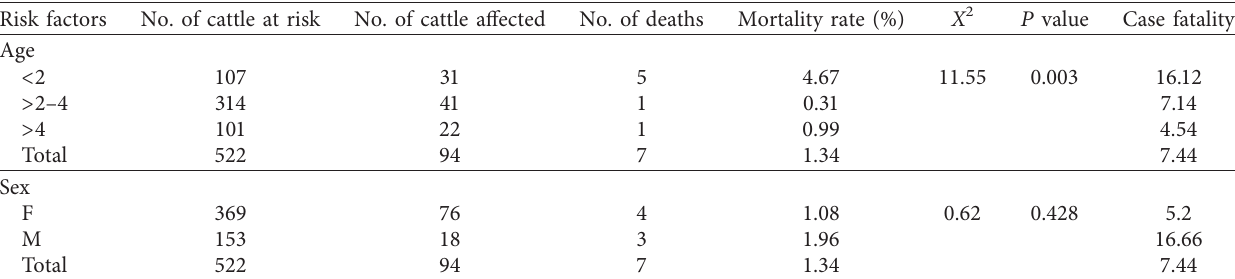
Table 3: Mortality rate in association with risk factors of age and sex.